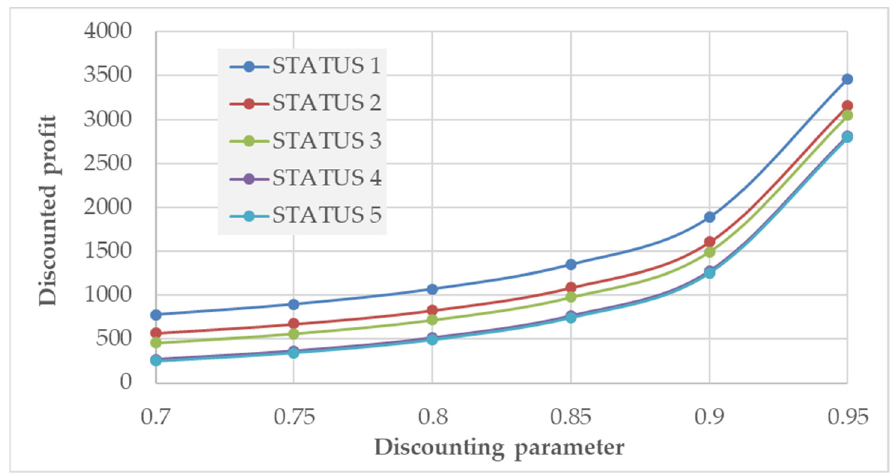
Figure 9. Impact of the discounting parameter on the discounted energy-consumption-based profit resulting from the optimized maintenance policy in the case of different initial status of the system (best status is Status 1 and worst status is Status 5).